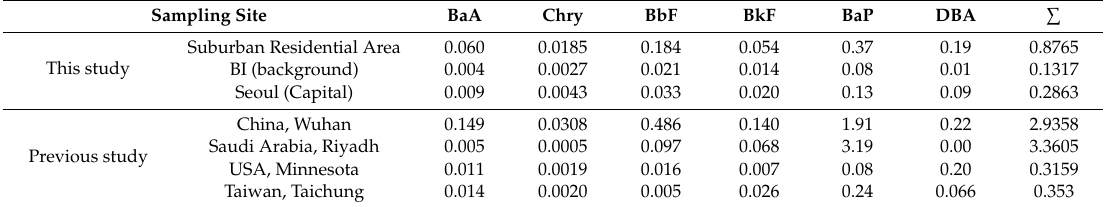
Table 2. Comparison of BaP TEF toxicity in the study area and in previous studies. Sampling